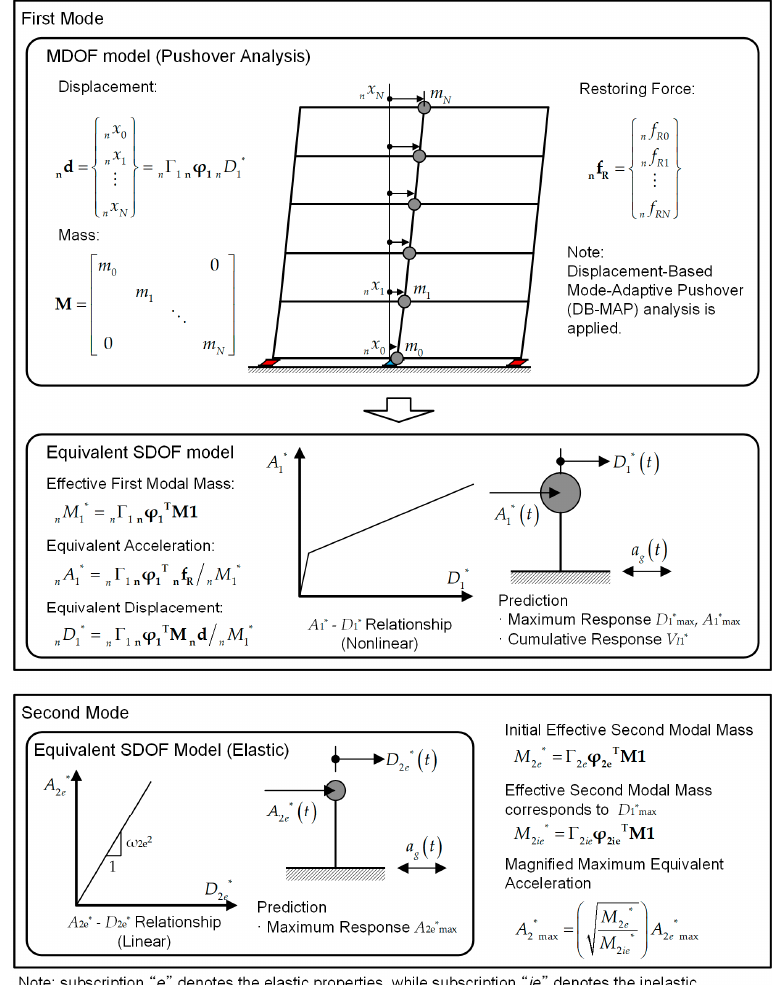
Figure 1. Concept of two equivalent single-degree-of-freedom (SDOF) models representing the first and second modal responses used in the proposed procedure. In the proposed procedure, the behavior of the equivalent SDOF model representing the first modal response is assumed as nonlinear, while the behavior of the equivalent SDOF model representing the second modal response is assumed as linearly elastic. These assumptions are the same as those made in a previous study [25], wherein the higher mode response was approximated by assuming linearly elastic behavior.